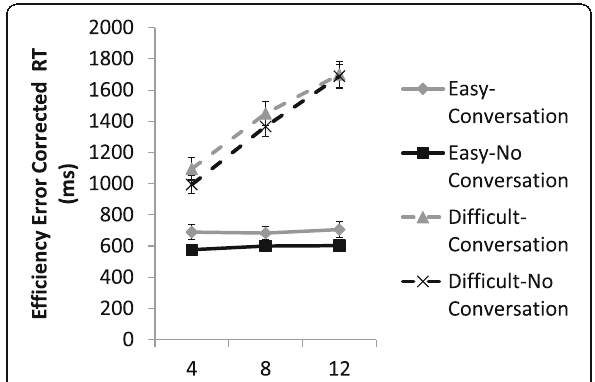
Fig. 7 Efficiency across set size for each condition in experiment 2. Error bars represent the standard error. RT, reaction